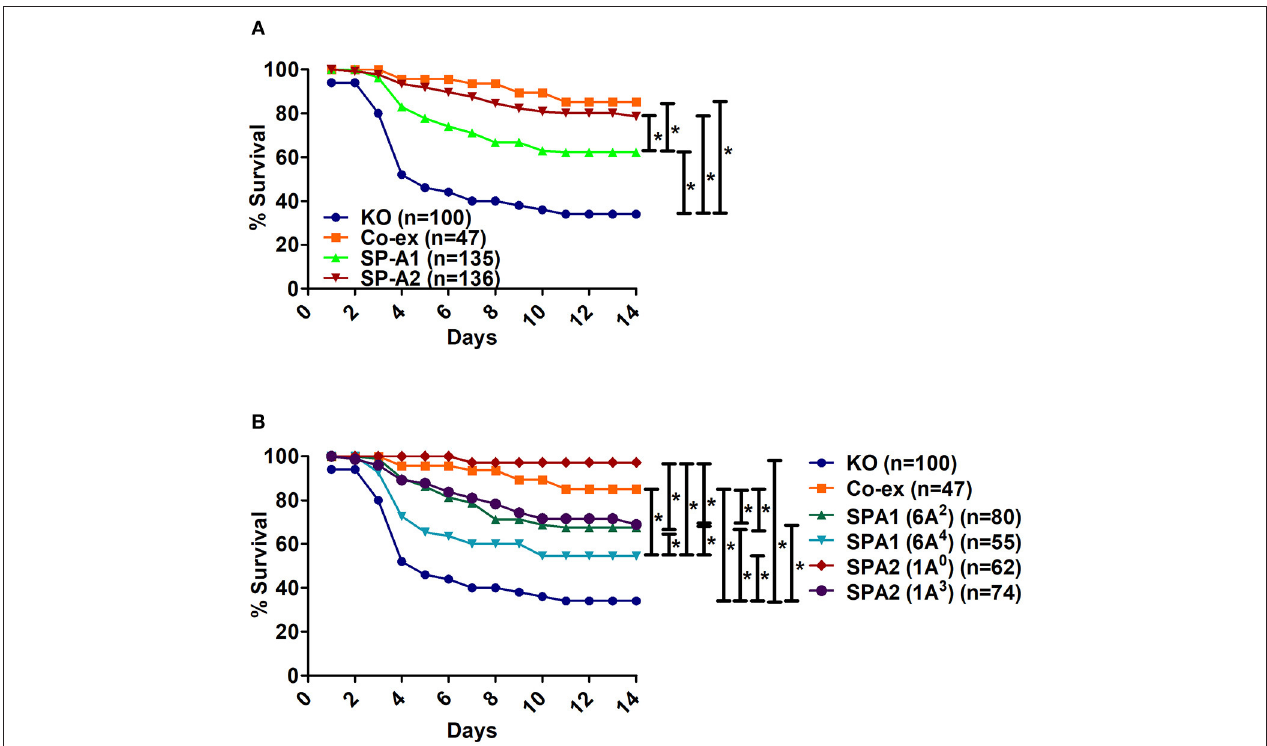
FIGURE 1 | Comparison of survival after K. pneumoniae infection. (A) Depicts differences in survival of male and female mice carrying a single SP-A1 or SP-A2 variant or both SP-A1 and SP-A2 (co-ex) variants and lacking SP-A (KO). (B) Depicts differences in survival of KO, SP-A2 (1A 0 , 1A 3 ), SP-A1 (6A 2 , 6A 4 ) and co-ex (males and females combined). Significant differences are indicated for survival * p <